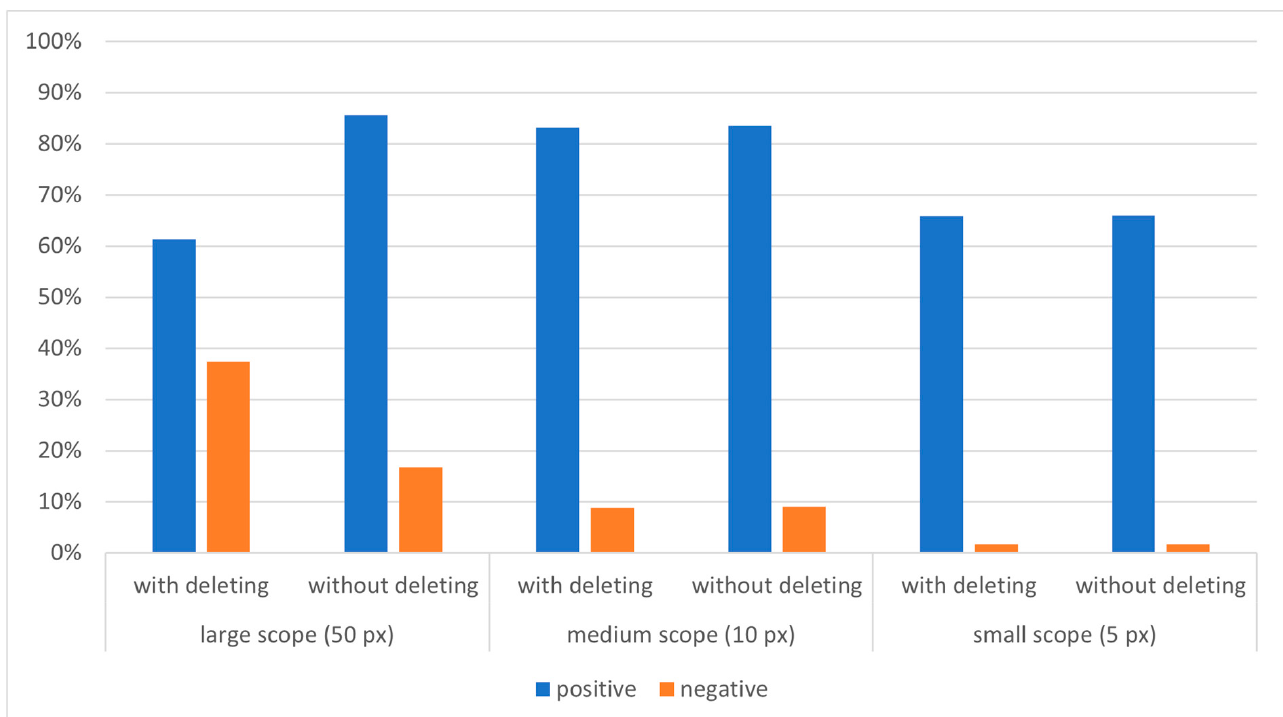
Figure 4. Share of correctly and incorrectly classified markers depending on the search scope used and whether or not the previously classified markers were removed from the images.